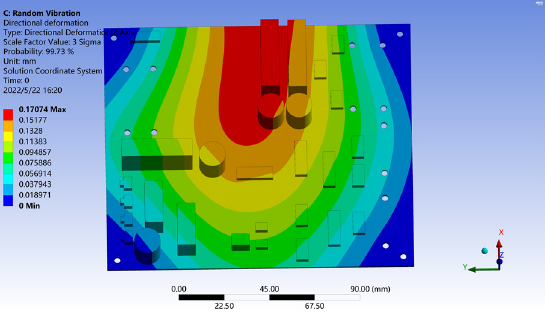
Figure 13. Deformation results of the PCB under random vibration excitation in the loading